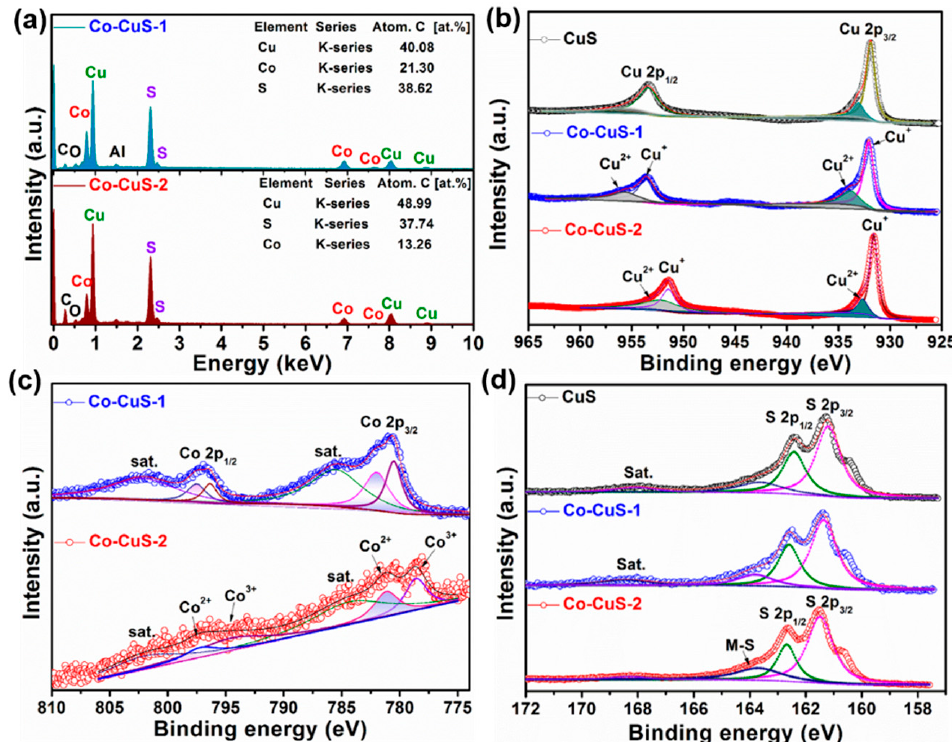
Figure 4. ( a ) EDS of CuS-1 and Co-CuS-2 samples. High resolution XPS spectra of Cu ( b ), Co ( c ), and S ( d ) for CuS, Co-CuS-1, and Co-CuS-2 samples. Figure 5a shows the CV curves of the bare electrode and copper cobalt sulfide-modified electrodes in the 0.1 M NaOH electrolyte containing 1 mM Glu. As shown in Figure 5a, the bare electrode has almost no response, CuS- and Co-CuS-1-modified electrodes have weak redox peaks, and the Co-CuS-2-modified electrode has a pair of obvious redox peaks at 0.45/0.60 V (vs. Ag/AgCl), indicating that the Co-CuS-2 sample exhibits the best response to glucose. As shown in Figure 5b–d, the CV curves of CuS, Co-CuS-1, and Co-CuS-2 at different glucose concentrations further show that the redox peaks of the Co-CuS-2 electrode is the strongest, indicating that this material has the best electrocatalytic performance for glucose among the three samples. The possible oxidation mechanism of glucose may be described in the following three steps [22,23,26]: